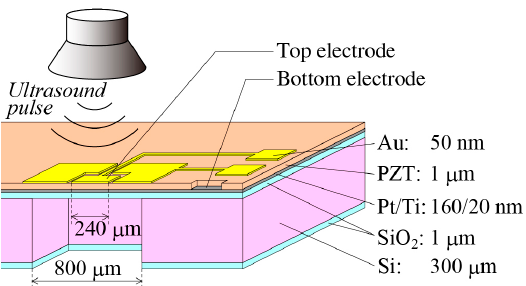
Figure 1. A schematic illustration of the sensor structure: an example of one with a square